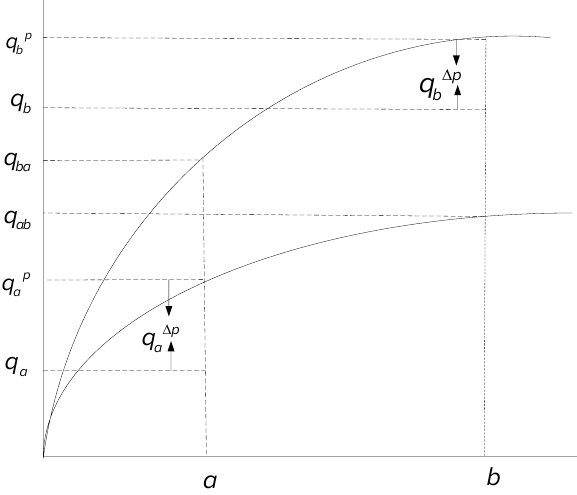
Figure 1. Model of grain quality improvement potential.